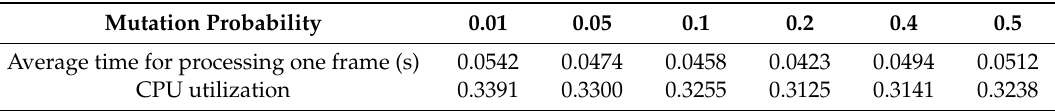
Table 2. The average time for processing one frame and CPU utilization to the mutation probability. Mutation Probability